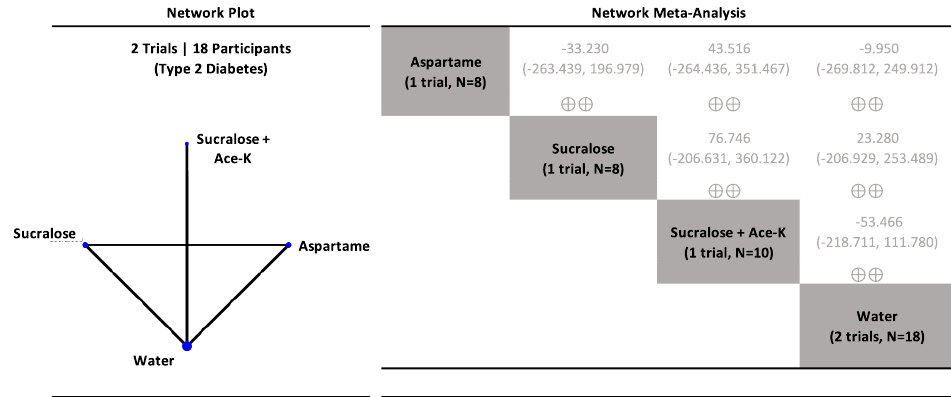
Figure 5. Network plot and meta-analysis of delayed coupling interventions evaluating the effect of non-nutritive sweetened beverages (NNS beverages) sweetened single or blends of non-nutritive sweeteners (NNS), water, and sugar-sweetened beverages (SSBs) sweetened with caloric sweeteners on postprandial blood glucose response in participants with type 2 diabetes. Network plot: the size of the blue nodes is proportional to the number of participants and the line width is proportional to the number of studies. Network table: treatments are grouped by treatment type (i.e., individual non-nutritive sweeteners (NNS), NNS blends, water, and caloric sweeteners) and are reported in alphabetical order. Treatment estimates (mmol*min/L) are MDs and 95% CIs of the column-defining treatment compared with the row-defining treatment. MDs less than 0 favor the column-defining treatment. MDs greater than 0 favor the row-defining treatment. Significant results are bolded in black. Non-significant results are grey and not bolded. The minimally important difference (MID) for postprandial glucose response is 100 mmol*min/L. Trivial (significant) effects (<1 MID) or no effects have a white background; small important effects ( ≥ 1 MID) have a light blue background; moderate effects ( ≥ 2 MID) have a darker blue background; large effects ( ≥ 5 to <10 MID) have a purple background; and very large effects ( ≥ 10 MID) have a black background. Confidence in the effect estimate is shown for each treatment comparison: high confidence ⊕⊕⊕⊕ ; moderate confidence ⊕⊕⊕ ; low confidence ⊕⊕ ; and very low confidence ⊕ . See Supplementary Table S18 and Figure S41 for detailed assessments of the confidence in the effect estimate using the CINeMA